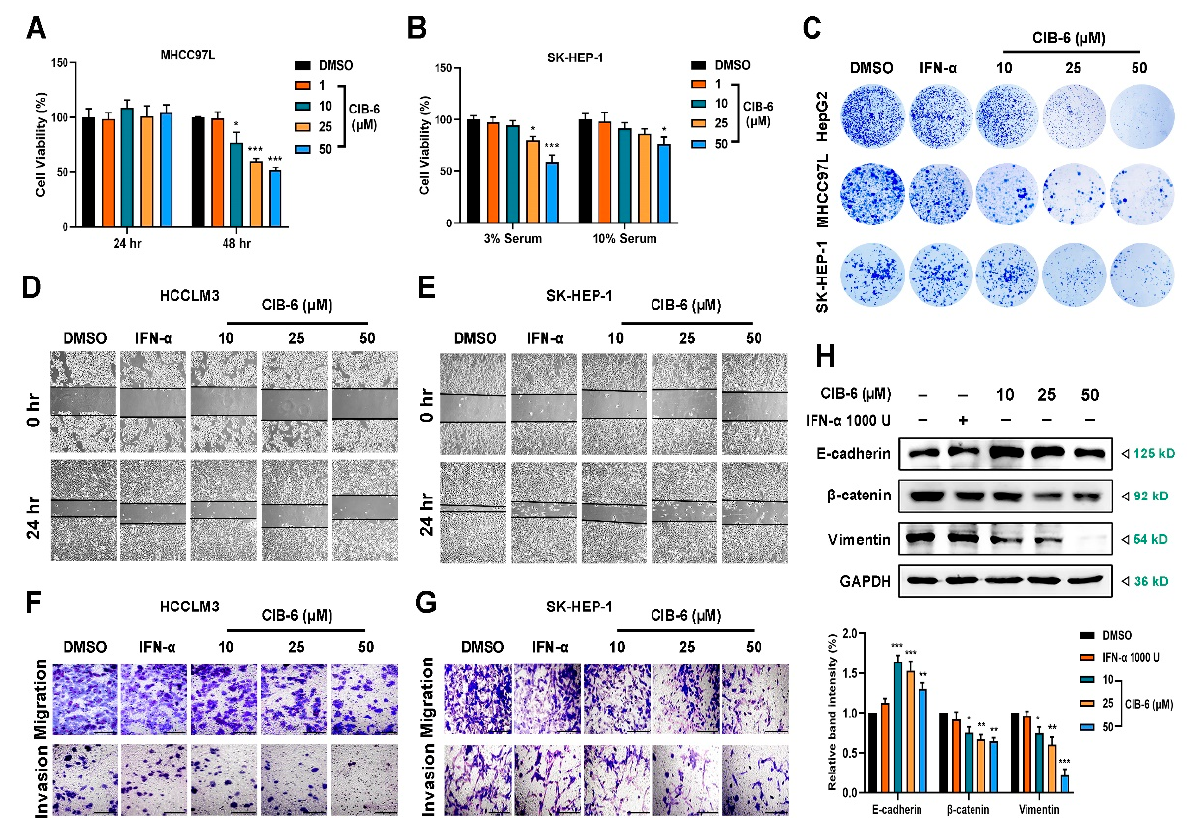
Figure 4. Effects of CIB-6 on the proliferation, migration, and invasion activity of human hepatocellular carcinoma (HCC) cells. ( A ) MHCC97L cell were treated with different concentrations of CIB-6 for 24 h or 48 h under the 10% serum condition (* p < 0.05 and *** p < 0.001 compared to the DMSO). ( B ) SK-HEP-1 cells were treated with CIB-6 for 24 h under different serum conditions. Cell viability was measured by cell counting kit-8 (CCK-8). All data are presented as mean ± SD of triplicate experiments (* p < 0.05 and *** p < 0.001 compared to the DMSO). ( C ) CIB-6 (10, 25, and 50 µ M) suppressed colony formation in HepG2, MHCC97L, and SK-HEP-1 cells. ( D , E ) Monolayers of HCCLM3 and SK-HEP-1 were scratched mechanically and treated with CIB-6 for 24 h ( × 40). ( F , G ) HCCLM3 and SK-HEP-1 cells seeded into the upper chambers (Matrigel embedded for invasion assays) of transwell inserts and treated with CIB-6 for 24 h. Cells were subsequently fixed and stained. Representative images obtained under a light microscope are displayed ( × 100). ( H ) Effects of CIB-6 on mesenchymal marker (E-cadherin, β -catenin, and Vimentin) expression in SK-HEP-1 cells. Bar graph shows quantified levels of proteins from three independent experiments (* p < 0.5, ** p < 0.01 and *** p < 0.001 as compared with DMSO).